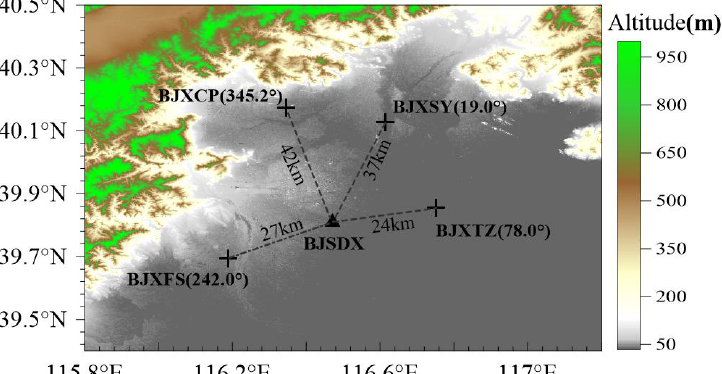
Figure 1. Distribution of radars (plus signs and triangles) and topography (shadings) over Beijing and its vicinity. Four plus signs indicate the locations of four X-POL radar sites (BJXFS, BJXCP, BJXSY, and BJXTZ). The triangle shows the location of BJSDX site. Distance and azimuth (0 deg in the north) of each X-POL radar relative to the BJSDX site are labeled.